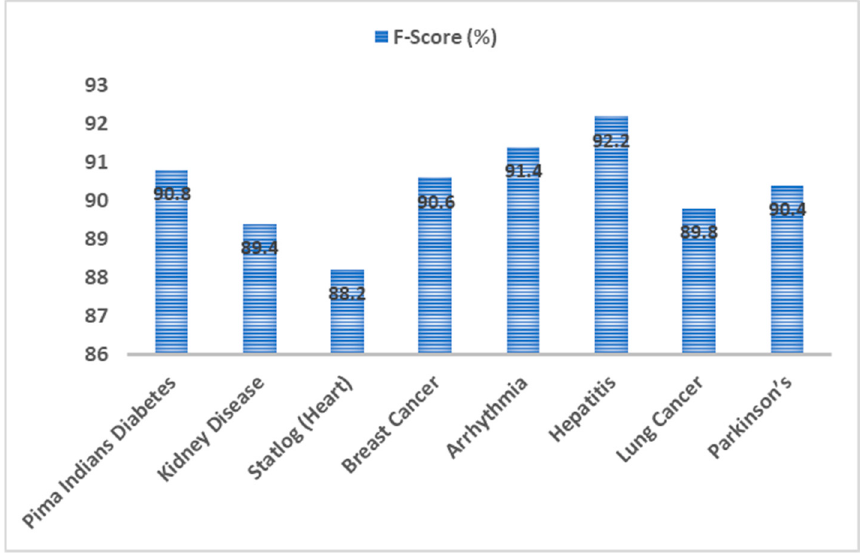
Figure 15. F-Score analysis of EAGA-MLP model over different chronic disease datasets.